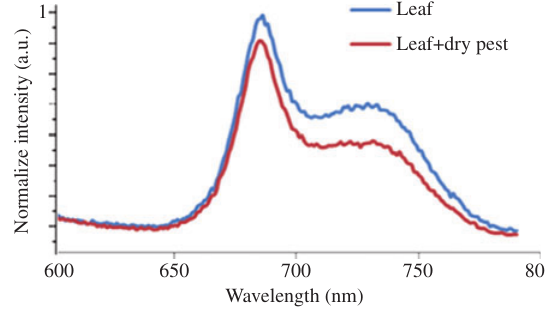
Figure 13 Autofl uorescence of pesticides: 1 µ l of each pesticide solution was applied and the spectra were obtained using LIF system. Excitation at 337 nm was provided by a nitrogen laser ( Hake et al. 2007 ).